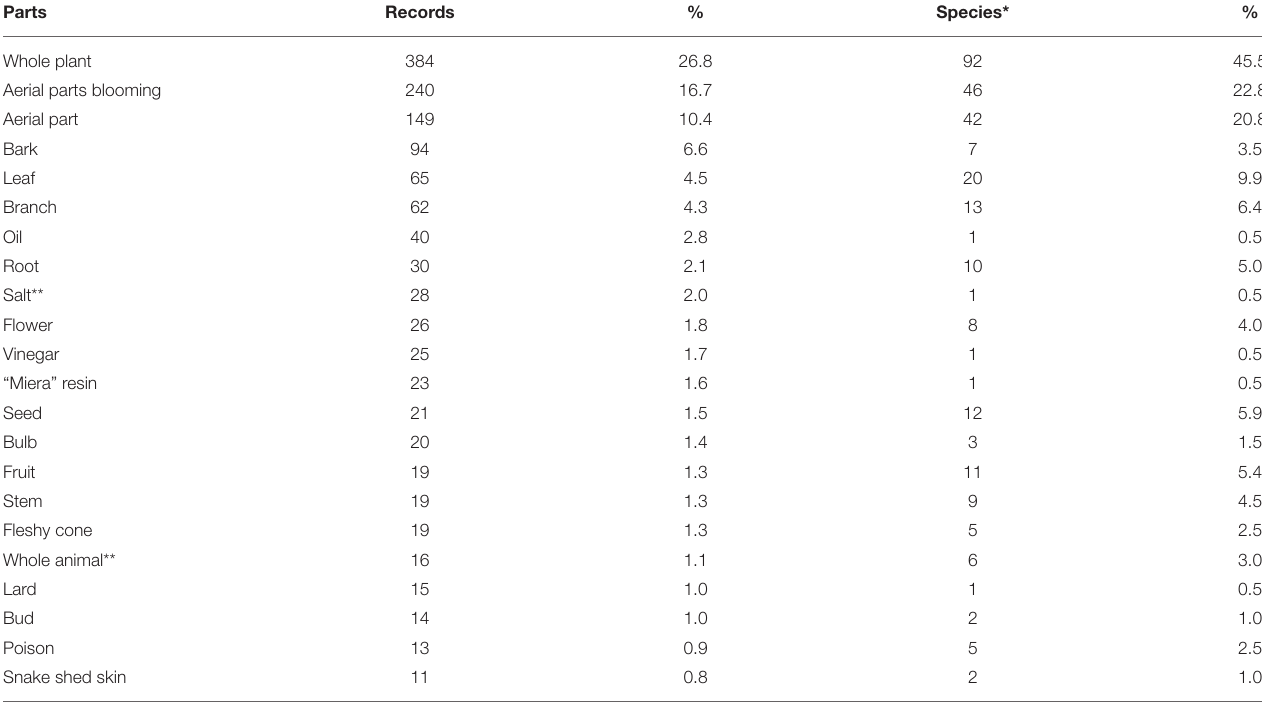
TABLE 1 | Frequency of plant parts among the recorded remedies.